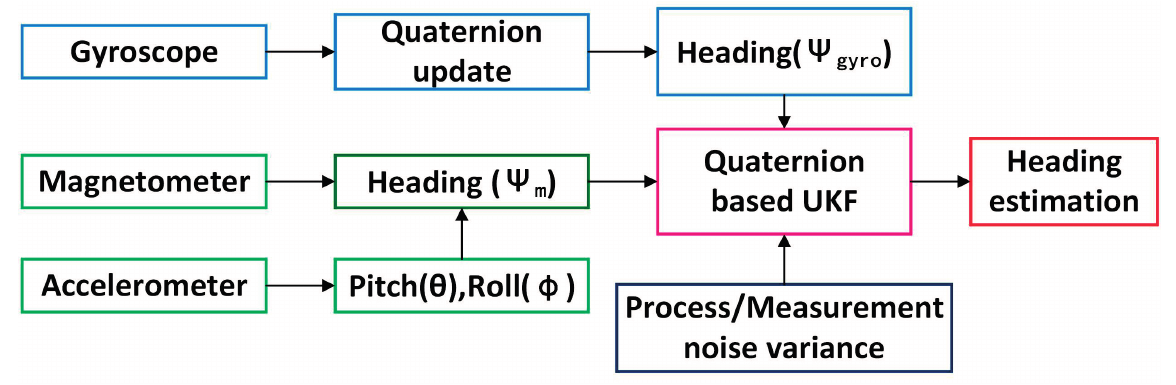
Figure 4. Flow chart of quaternion-based UKF for heading